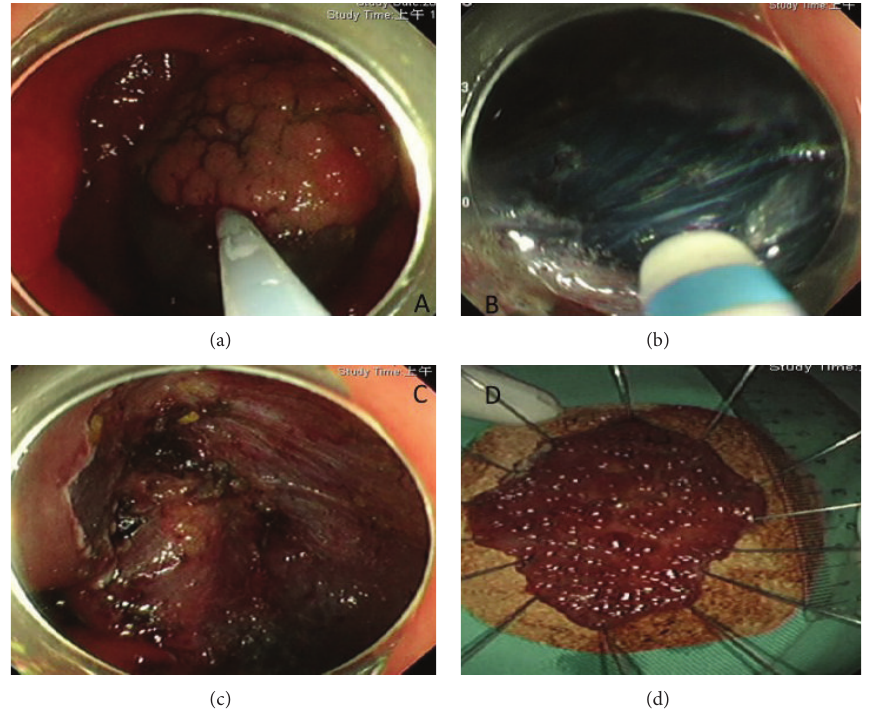
Figure 1: Process of endoscopic submucosal dissection. (a) A laterally spreading, granular, homogenous type tumor, 5.5 cm in diameter, was noted at ascending colon. Fluid was injected into submucosal layer to create cushion for mucosal incision and submucosal dissection. (b) Dual knife was used for submucosal dissection along the blue layer that was caused by indigo carmine being administered to enhance dissection plane. (c) The tumor was already resected en bloc . The artificially created ulcer base was checked carefully for muscular layer injury and exposed vessel. (d) The resected specimen was stretched and fixed well on a